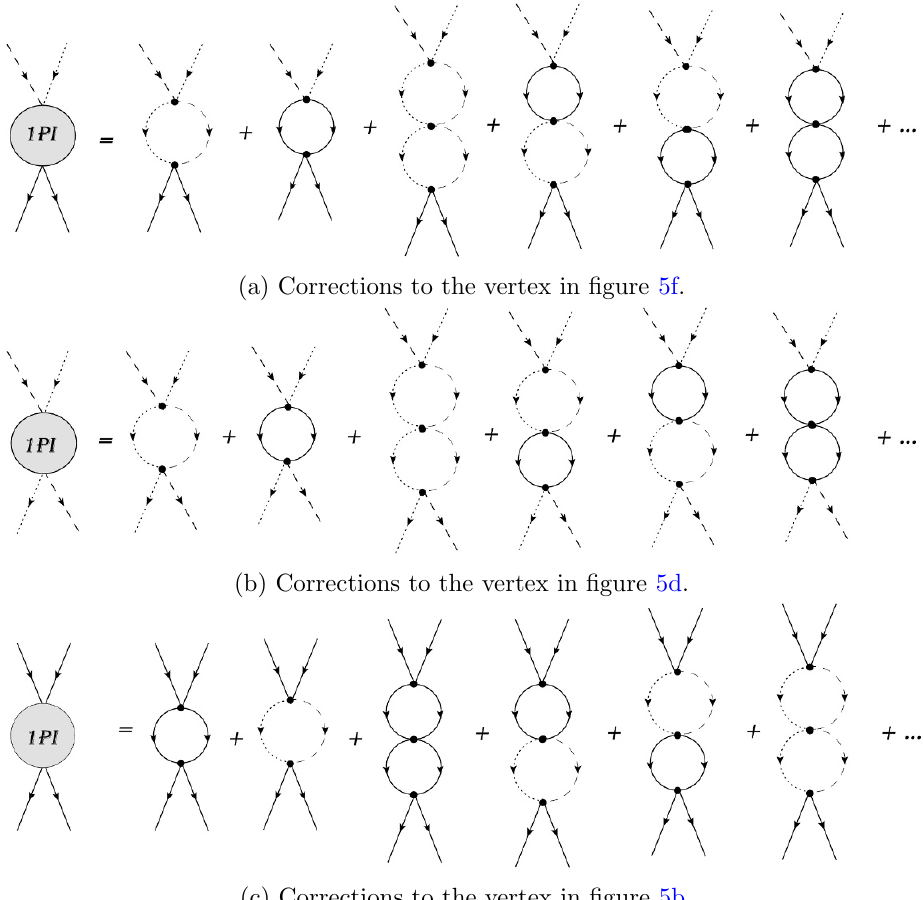
(b) Corrections to the vertex in (cid:12)gure 5d.